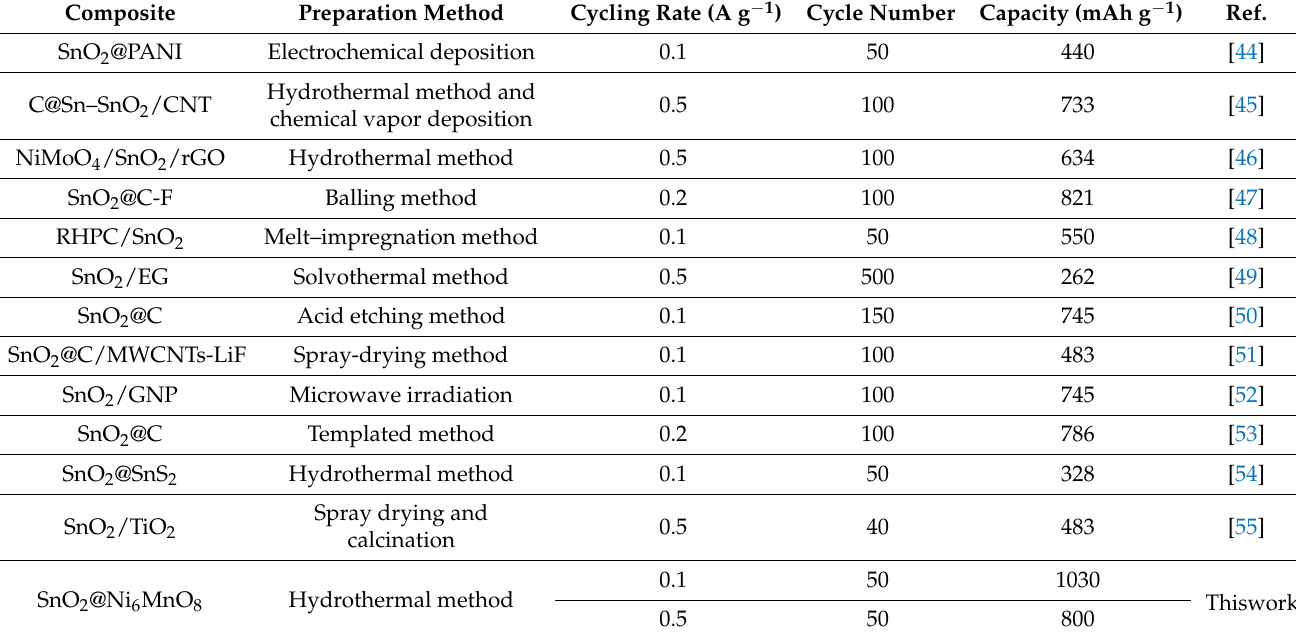
Table 1. Comparison of electrochemical performance of SnO 2